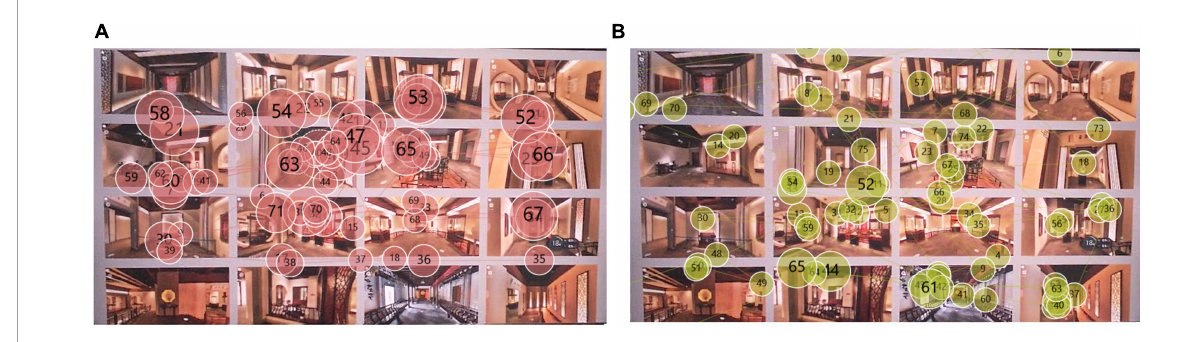
FIGURE8 Subject’s gaze trajectory: (A) subject 1’s gaze trajectory; (B) subject 2’s gaze trajectory.